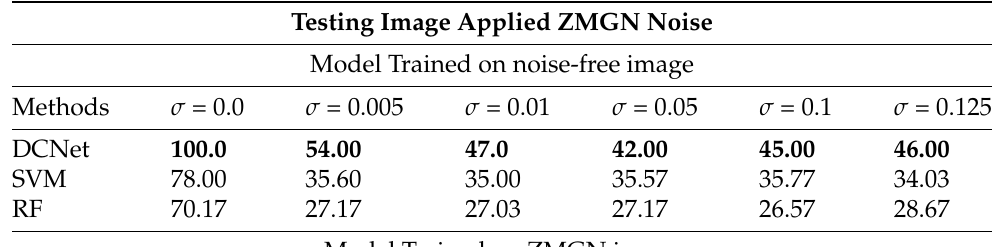
Table 1. Comparison of accuracy value with traditional machine learning on zero mean Gaussian noise (ZMGN) testing images. Bold fonts indicate the best